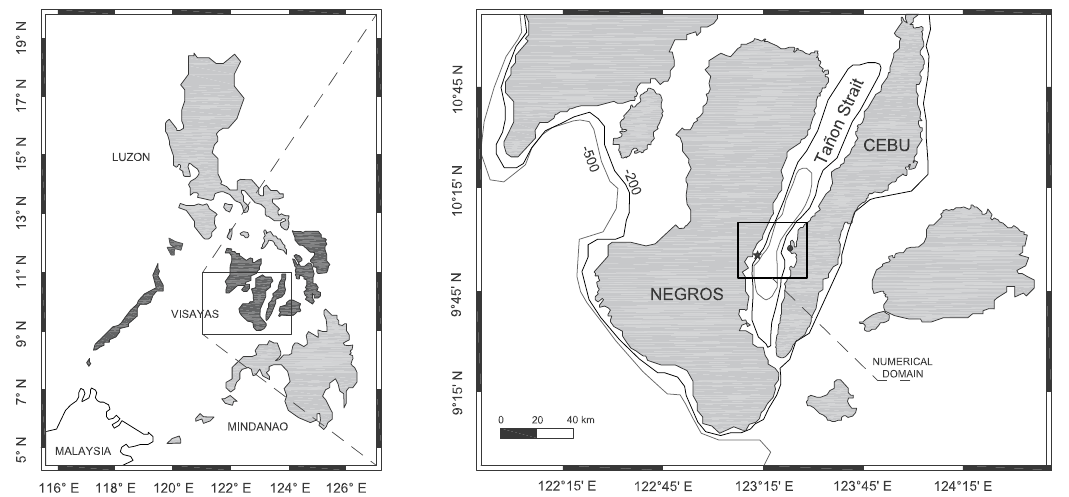
Figure 1. Map of the Philippines Archipelagos, ( left ); closer view of Negros and Cebu islands, ( right ). The black star is located at the epicenter position, while the black dot is approximately at the scuba-diver position during the earthquake. The rectangle indicates the domain reproduced